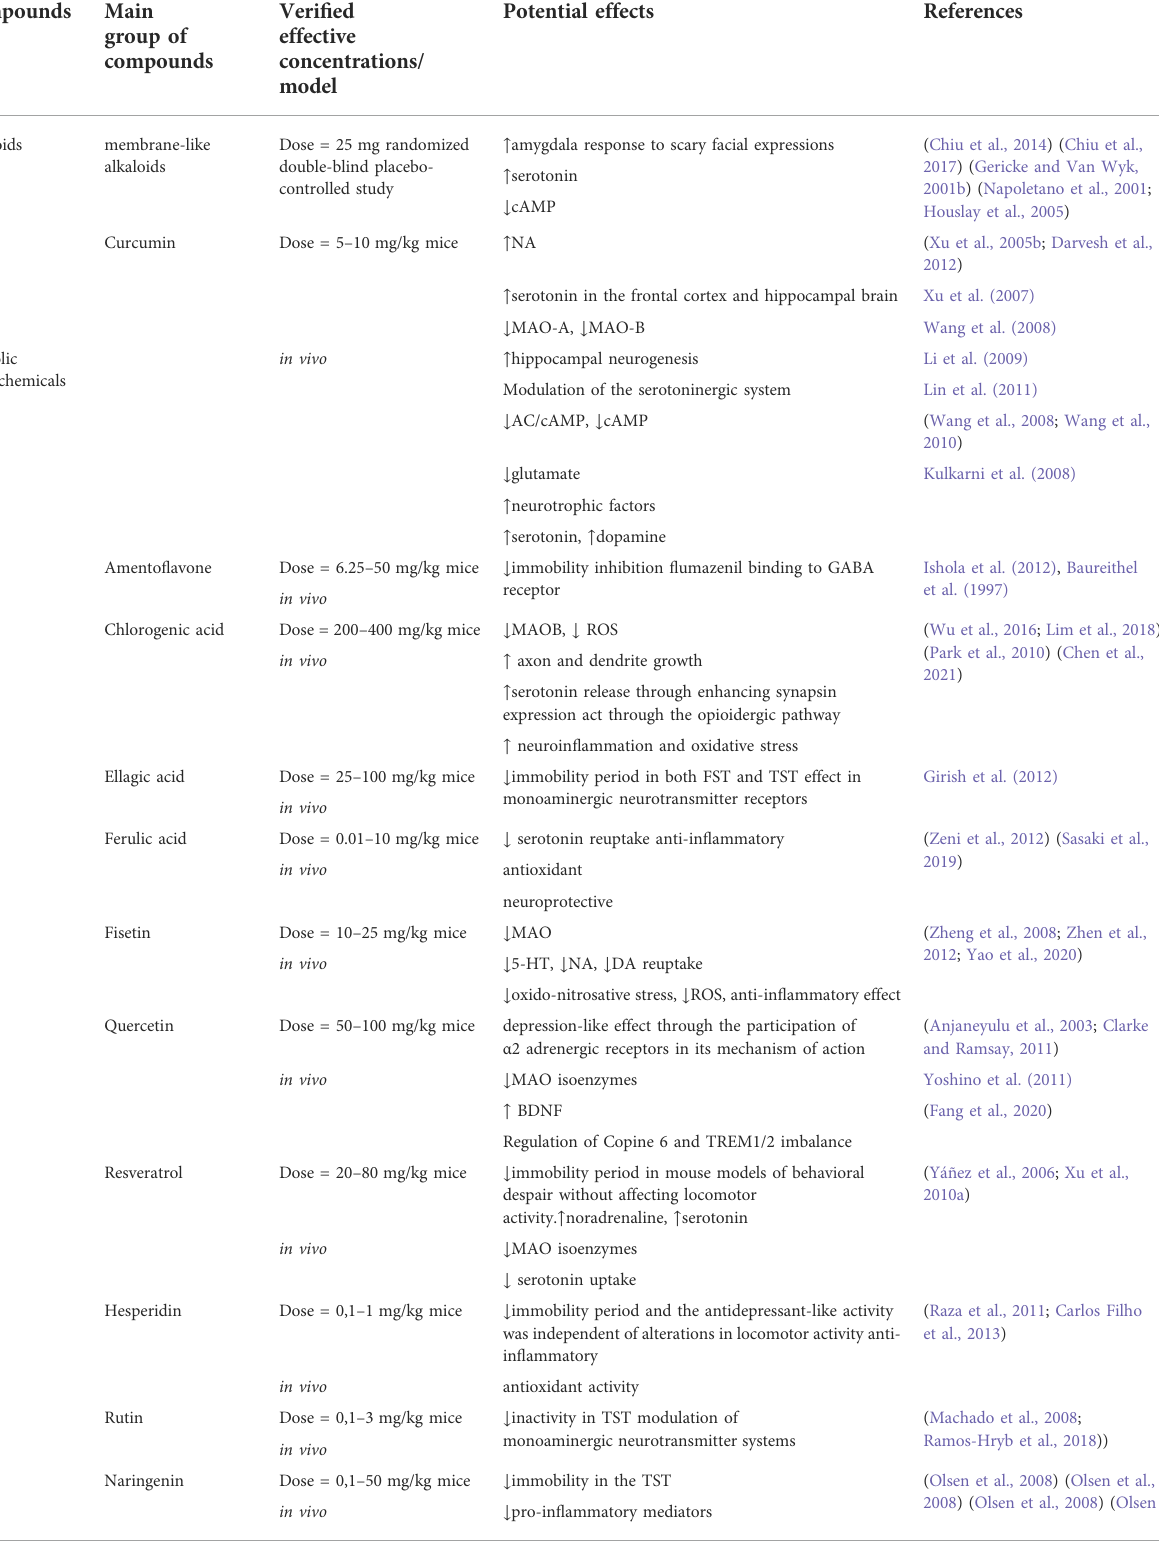
TABLE 2 Summarizes the effects and potential effects for the most important phytochemicals as a promising therapy for treating major depressive